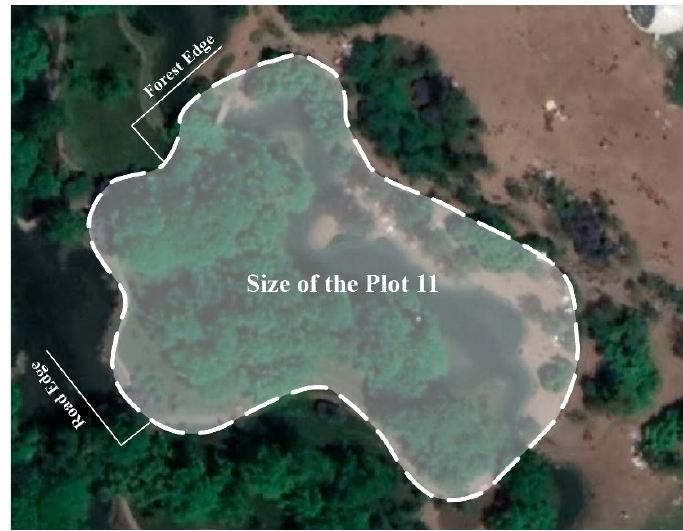
Figure A2. The schematic diagram of field measurement methods.